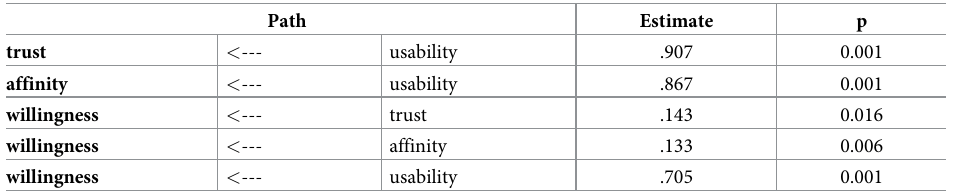
Table 2. Direct effects in the present